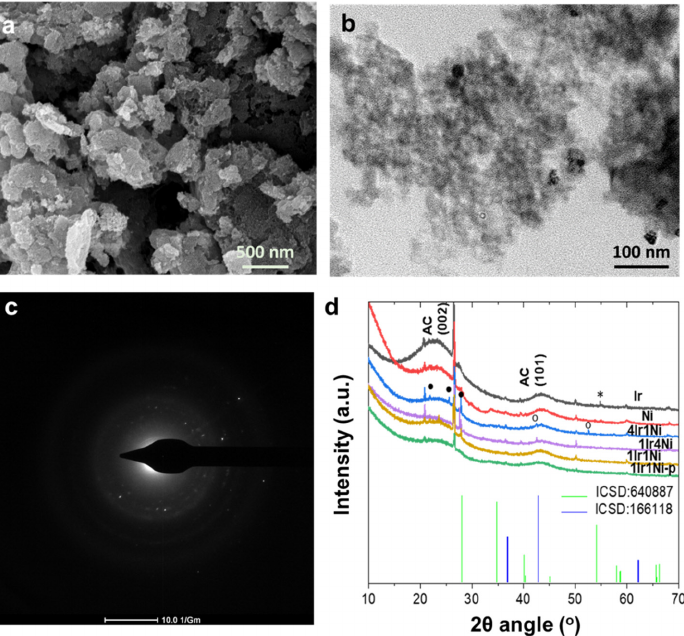
Figure 3. ( a ) SEM and ( b ) TEM representation of 4Ir1Ni@AC; the scalar bar is specified in the image. ( c ) SAED diffraction pattern of 4Ir1Ni@AC and ( d ) powder X-ray diffraction pattern in the 10–70 o 2 θ angle range, with peak tips marked with (*) for IrO 2 , (•) for alloy, and (°) for Ni, peaks of AC are indexed with ‘AC’ prefix. ICSD 640,887 and ICSD 166,118 refer to the standard diffraction peak patterns of IrO 2 and NiO,